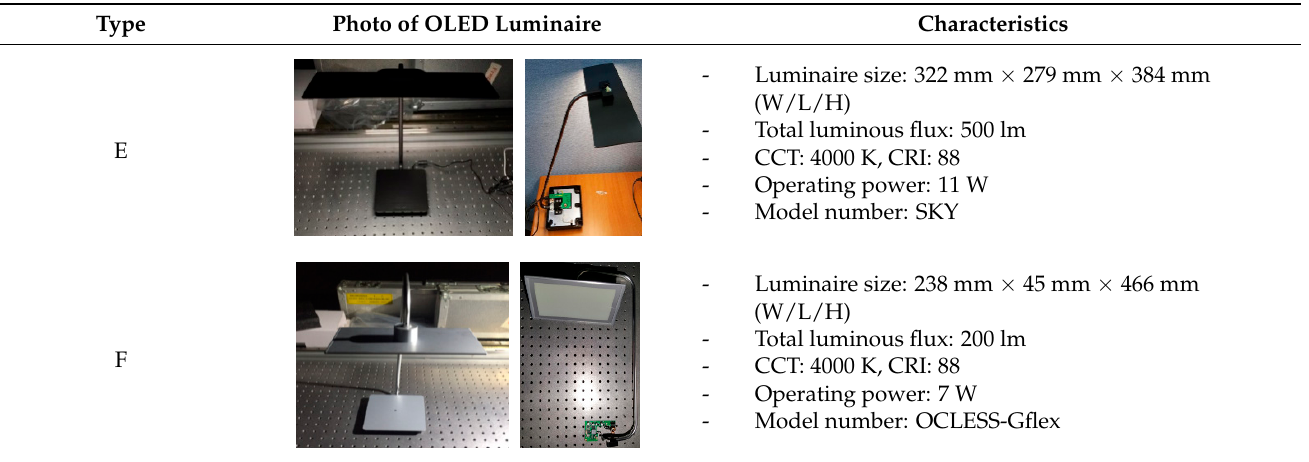
Table 2. OLED luminaires used in the experiment.